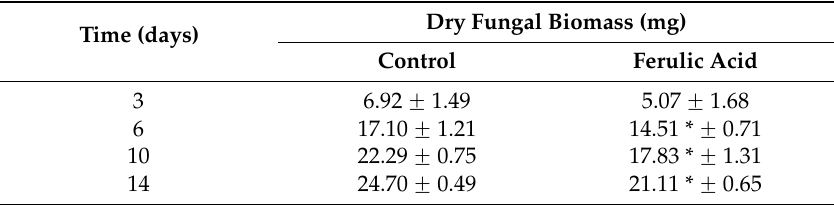
Table 2. Effect of ferulic acid (1 mM) on dry fungal biomass of F. langsethiae incubated at 25 ˝ C. Values expressed as mean values ˘ SD of three biological